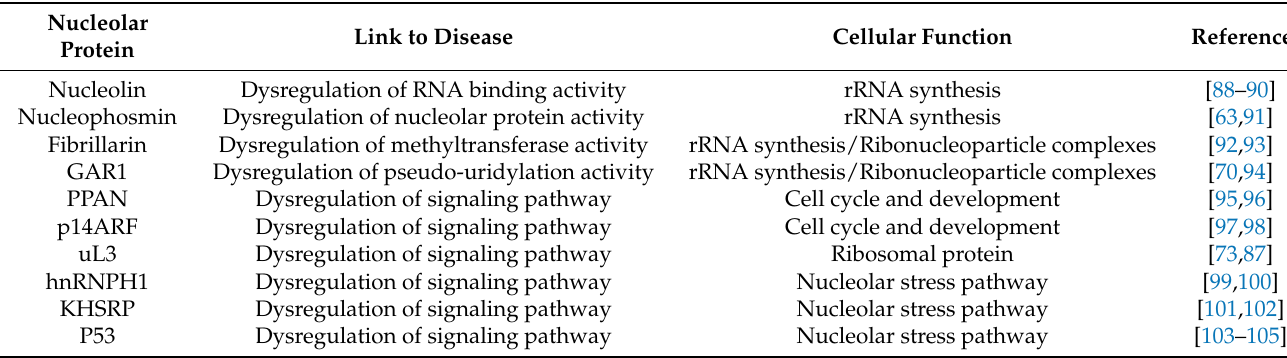
Table 1. Protein nucleolar component related to clinical disease. Nucleolar proteins are often dysregulated in several types of cancers and important clinical diseases. A brief list of examples is described in the table with the functional activity inside the cell and the dysregulated activity presented in the